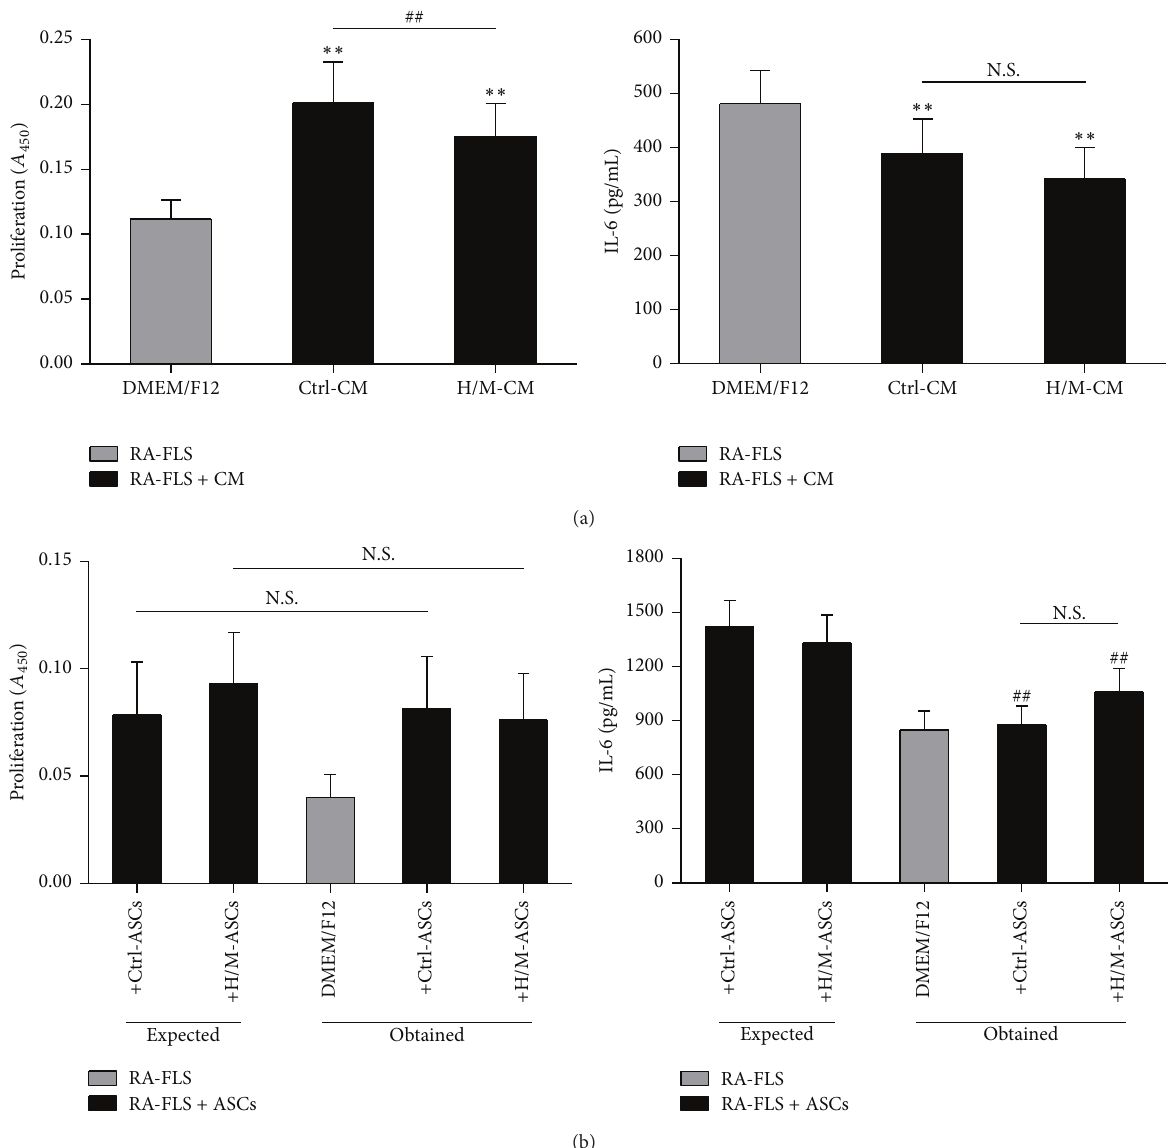
Figure 2: Effects of unstimulated and HMW/MMW adiponectin-stimulated RA-ASCs on RA-FLS function. RA-FLS were cultured either in conditioned media (CM) collected from RA-ASCs (a) or in the presence of RA-ASCs (b). For coculture experiments, unstimulated ASCs (+Ctrl-ASCs)orASCsstimulatedwith10 𝜇 g/mLofHMW/MMWadiponectin(+H/M-ASCs)wereused,whereasCMfromrespectivecultures of unstimulated (Ctrl-CM)and stimulated (H/M-CM)ASCswere added to FLS. RA-FLS cultured separately (DMEM/F12)served as a control. Proliferation of cells was determined by BrdU incorporation assay. Absorbency of samples was measured at 450nm ( A 450 ). IL-6 was detected by specific ELISA test. (a) The effects of ASC-CM on RA-FLS proliferation ( 𝑛 = 14 ) and IL-6 secretion ( 𝑛 = 17 ). (b) Proliferation ( 𝑛 = 6 ) and IL-6 ( 𝑛 = 9 ) secretion in ASCs-FLS cocultures. Expected: the sum of the values obtained for separate FLS and ASCs cultures; obtained: real valuesstatedinthecocultures.Asterisks( ∗ )indicatestatisticallysignificantdifferences versus DMEM/F12;hashmarks(#)indicatestatistically significant differences between indicated data or between expected and obtained values; ∗∗/ ## 𝑝 < 0.01 ; N.S.: